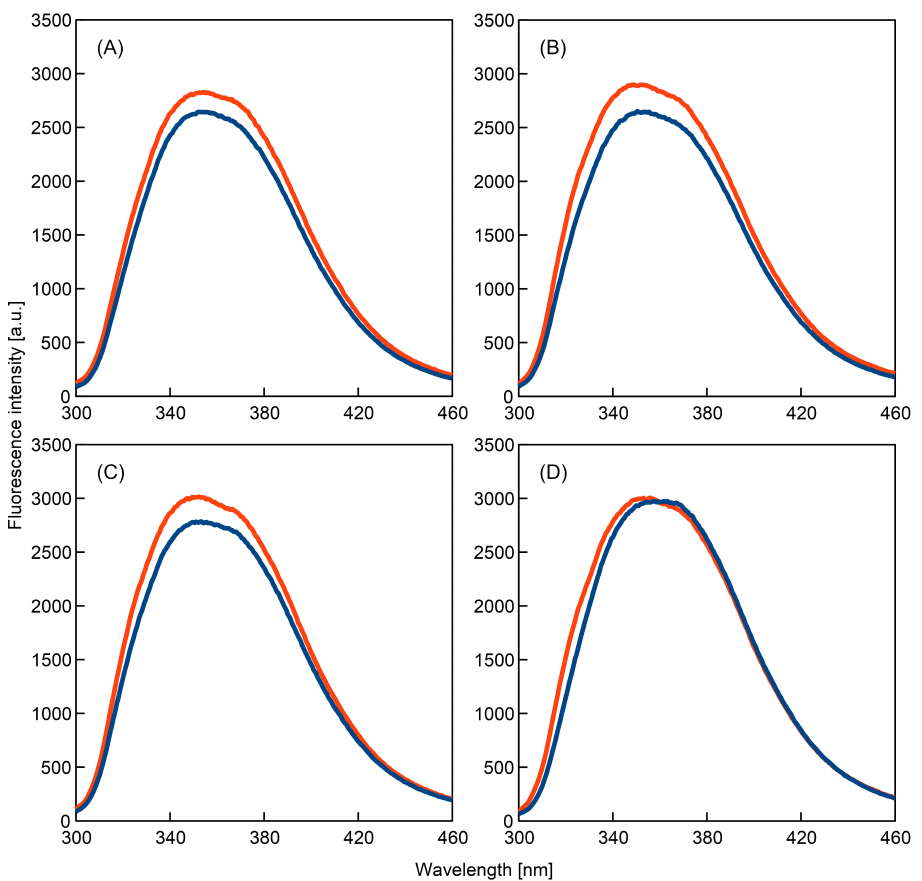
Figure 6. Intrinsic fluorescence of the K-peptide in freshly prepared solutions (dark blue line) and its fluorescence after incubation at 37 ◦ C for 14 days (red line). The peptide was dissolved in: ( A ) water; ( B ) acetate buffer, pH = 4, without additives; ( C ) acetate buffer with dimethyl sulfoxide and ( D ) acetate buffer with